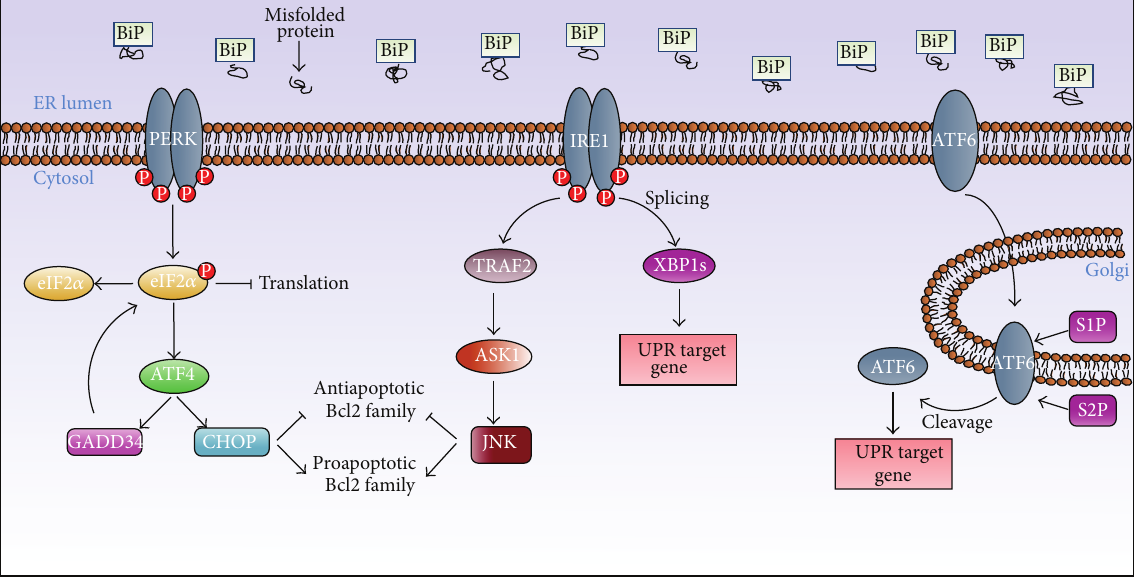
Figure 1: As a consequence of ER stress cells activate signal transduction pathways collectively known as unfolded protein response (UPR). The figure represents the three branches of the UPR and the corresponding UPR sensors (PERK, IRE1, and ATF6).